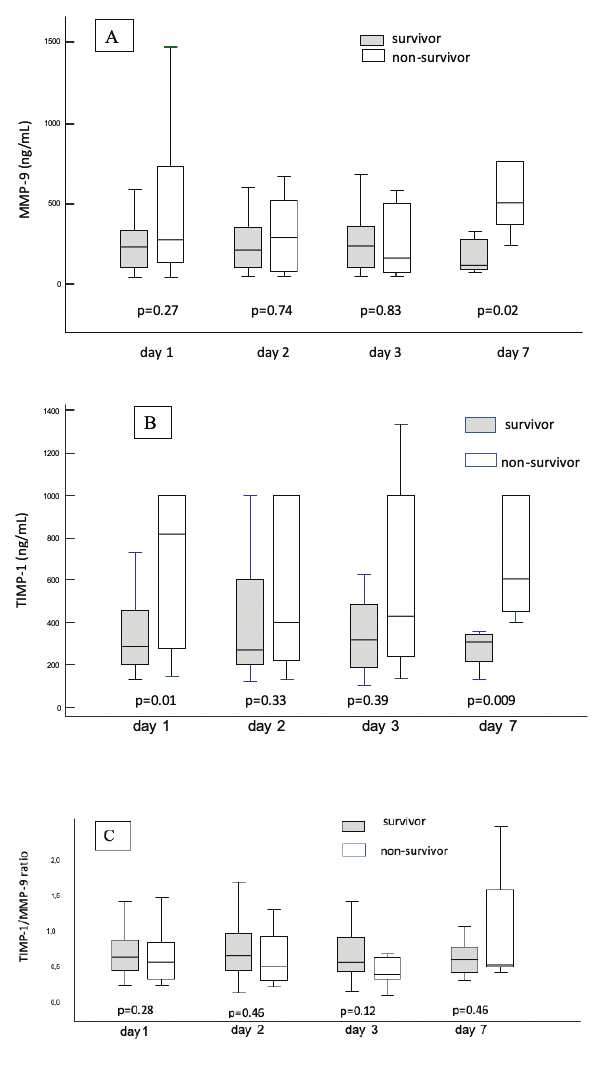
Figure 2: Correlation between MMP-9 and TIMP-1 on day 1 of ICU hospitalization.